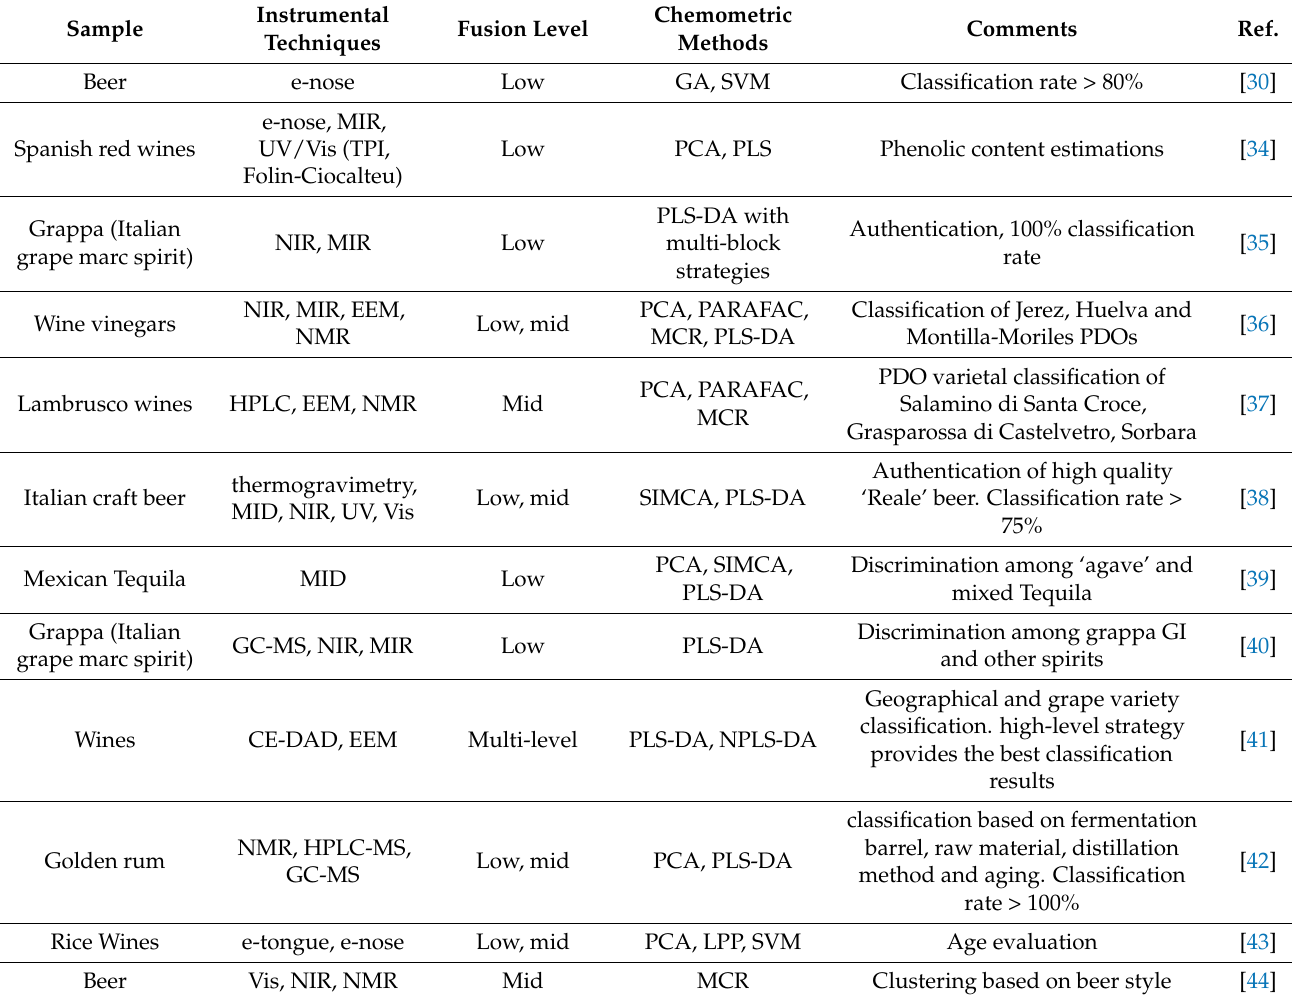
Table 1. Applications of data fusion approaches to the characterization of alcoholic